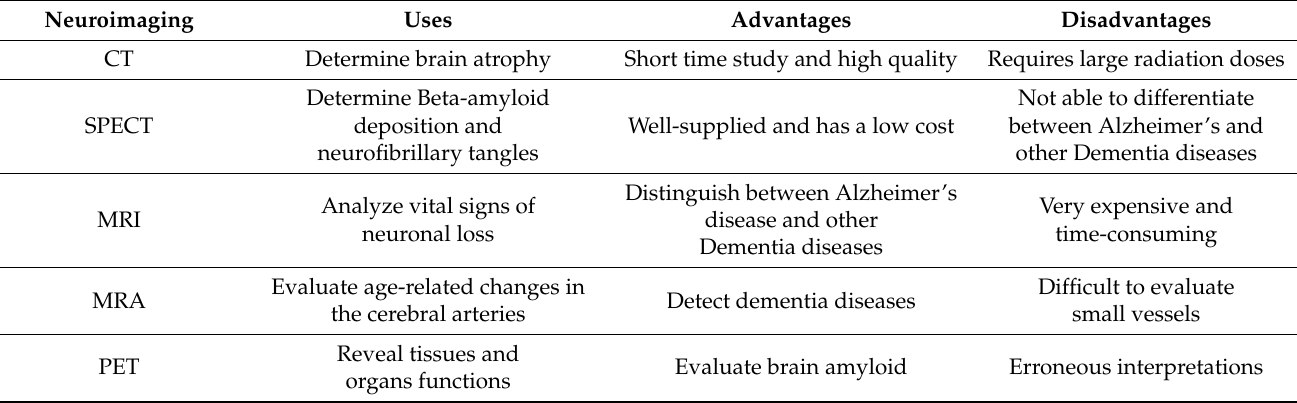
Table 1. The uses, advantages, and disadvantages of neuroimaging